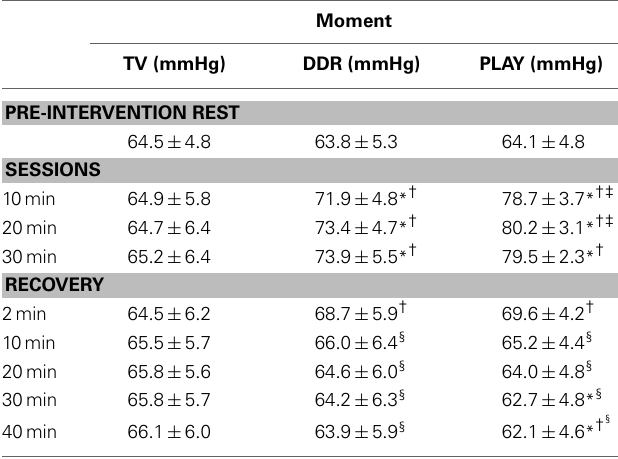
Table 3 | Diastolic blood pressure mean values ( ± SD ) of all sessions (TV, DDR, and PLAY) ( n =